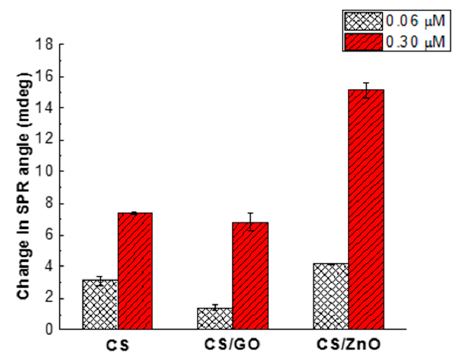
Figure 6. Sensitivity of glyphosate sorption via a change in angle on CS film alone, CS/GO, and CS/ZnO film cross-linked by GA for two glyphosate concentrations (0.06 and 0.30 μ M), at pH 5.5.